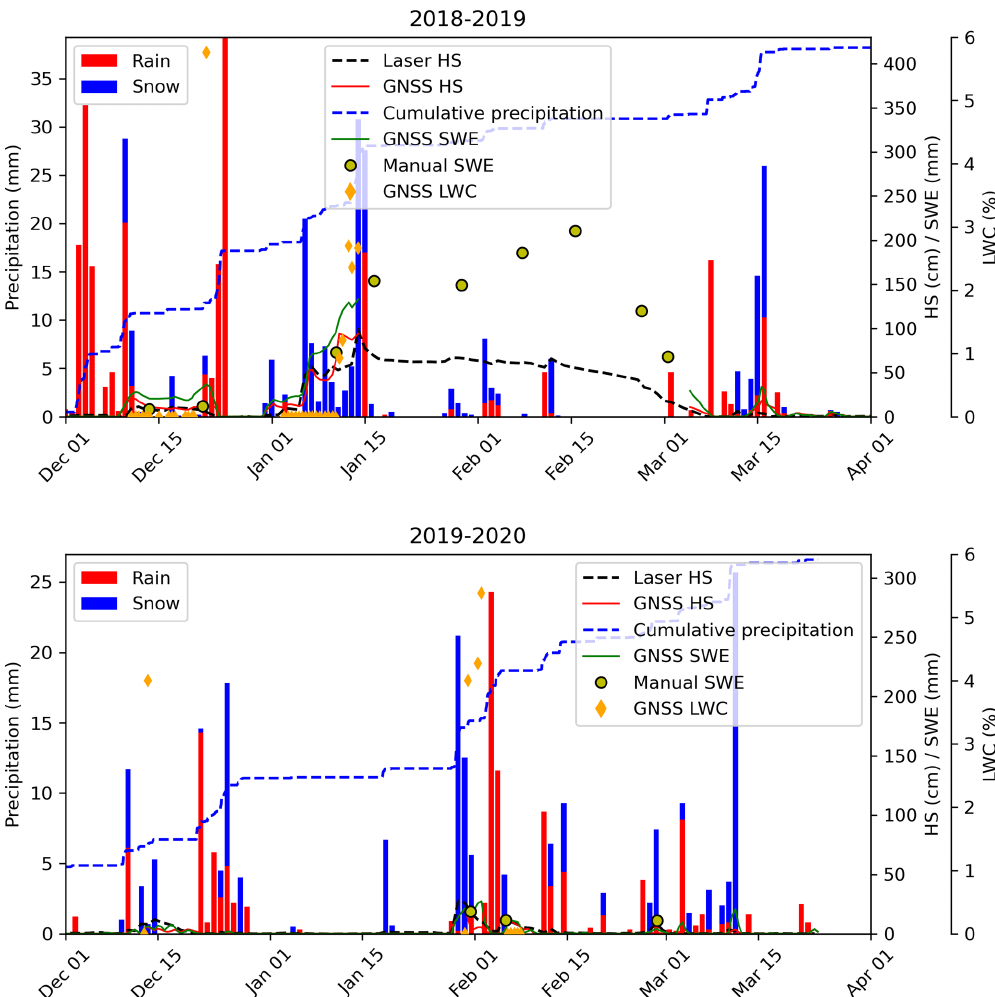
Figure B4. Seasonal evolution of GNSS-derived SWE and HS and corresponding reference data for Küblis. The blue columns correspond to precipitation in the form of snow; the red columns correspond to rain. Reference precipitation was measured by a pluviometer and classified as rain for air temperature T > 1.1 ◦ C and as snow for T ≤ 1.1 ◦